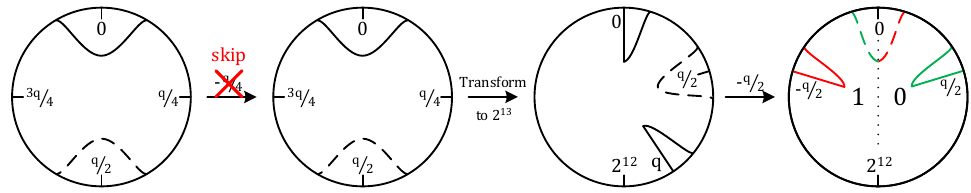
Figure 9: Visualization of the effect of skipping the first subtraction in the masked decoder of Oder et al.